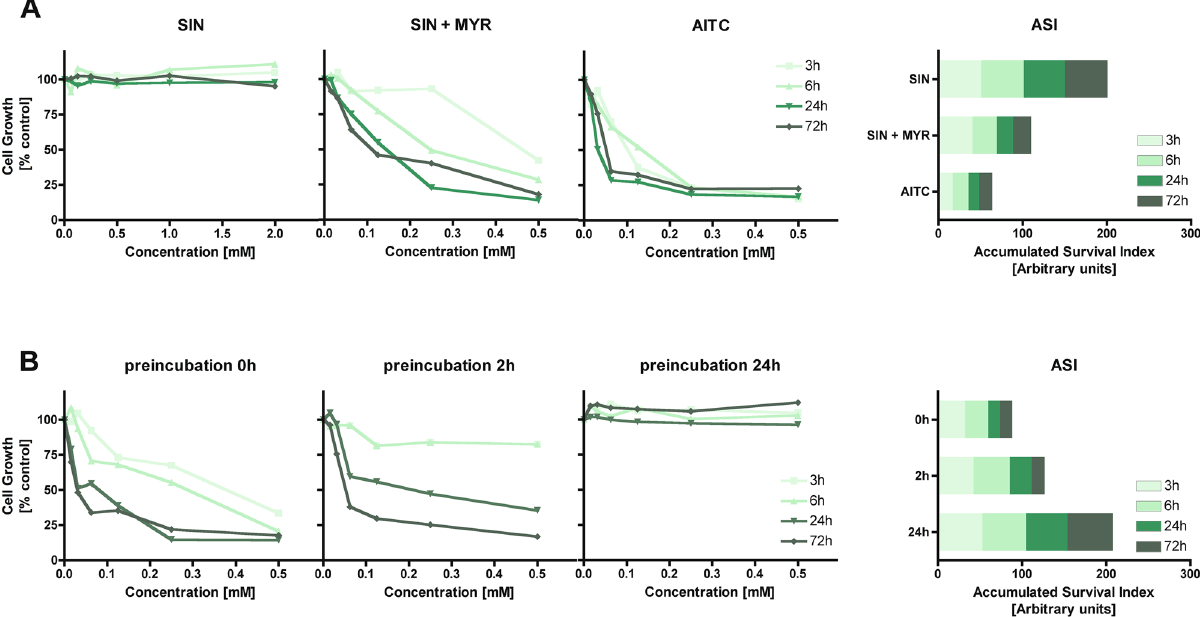
Figure 2. Growth inhibition of human adenocarcinoma cancer cells (HT29) treated with GL or its derivative directly ( A ) or after preincubation with myrosinase ( B ) evaluated by MTT test after different incubation periods (3, 6, 24, and 72 h). ( A ) Cells exposed to sinigrin (SIN), sinigrin, and myrosinase (SIN + MYR) or SIN hydrolysis product—allyl isothiocyanate (AITC). ( B ) Cells exposed to the combination of SIN and MYR incubated before cell treatment for different periods (0, 2, and 24 h). Accumulated Survival Index (ASI) is defined as the sum of areas under survival curves determined for individual treatments for the same concentration range (0–0.5 mM). The results represent the means of three independent experiments; SD values did not exceed